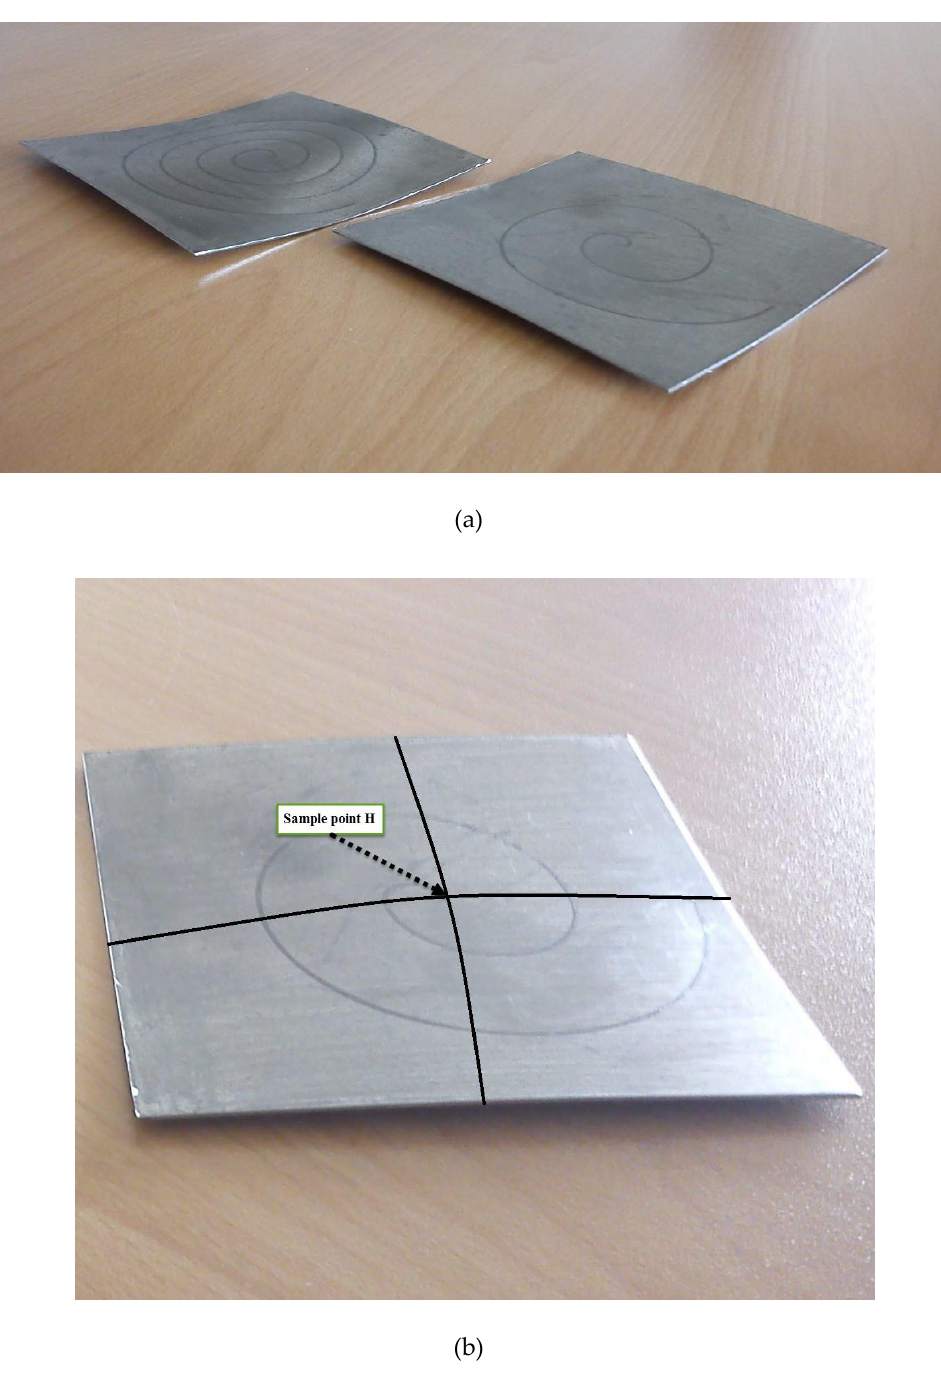
Figure 1. ( a ) Some laser-formed saddle-shaped surfaces with different spiral pitches; ( b ) Sample point H for measuring the deformation of the saddle